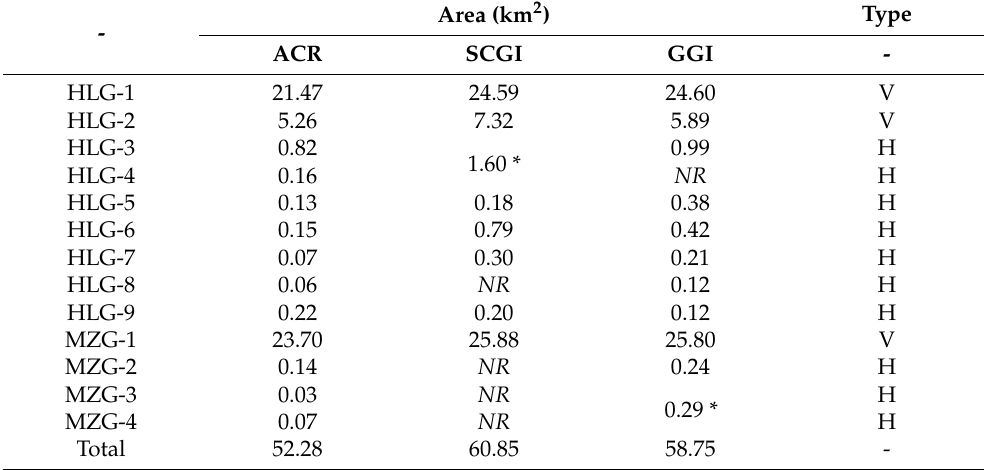
Table 3. Detailed information for each